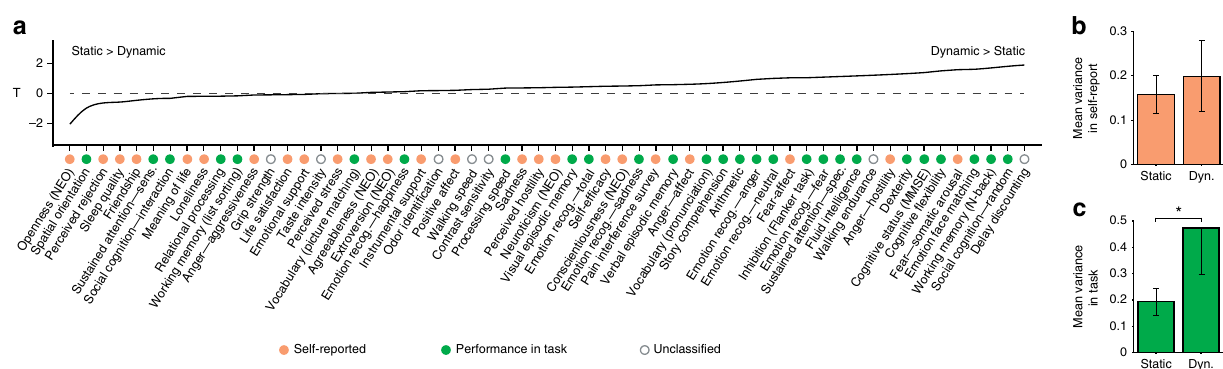
Fig. 2 Dynamic FC explains larger behavioral variance than static FC in task-performance measures. a Behavioral measures are ordered based on whether dynamic FC explains more variance than static FC. A positive t -statistic T suggests that dynamic FC explains more variance than static FC. Behavioral measures corresponding to task-performance are marked with a green dot and self-reported measures are marked with an orange dot. b No statistically signi fi cant difference ( p > 0.10: two-tailed t -test) was found in the mean variance explained by static and dynamic FC in self-reported measures. c Measures of performance in task are on average signi fi cantly better explained ( p = 1.75 × 10 − 3 ; two-tailed t -test) by dynamic FC. Error bars indicate SD of the